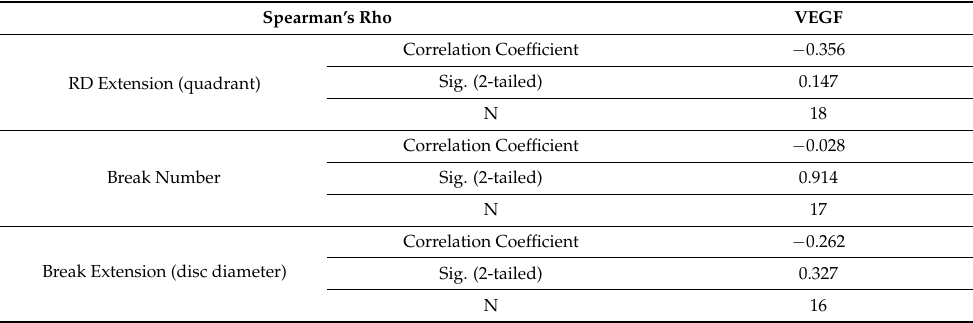
Table 3. Spearman Correlation Coefficient